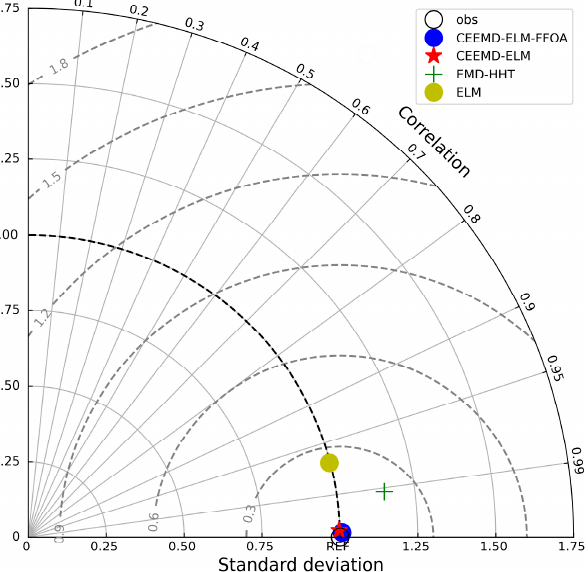
Figure 11. Taylor diagrams for statistical comparison of di ff erent models.